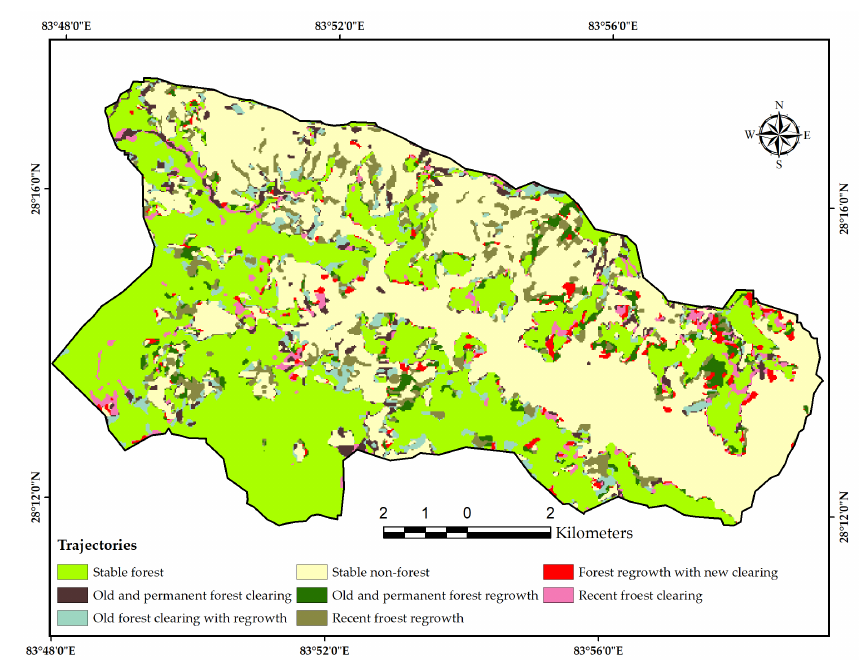
Figure 5. The trajectory classes of forest cover changes in Phewa Lake watershed for three time points 1995, 2005 and